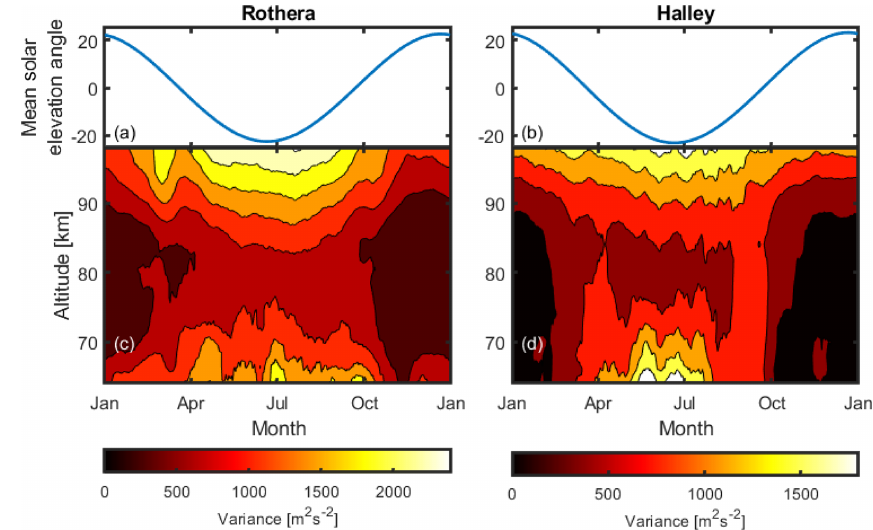
Figure 10. Trends in variance over the course of the year at Rothera (c) and Halley (d) with the daily mean angle of the Sun above the horizon (a, b) . Mean variance was calculated for each day and the result smoothed using a 15d running mean. Note the difference in colour scale between the two plots.